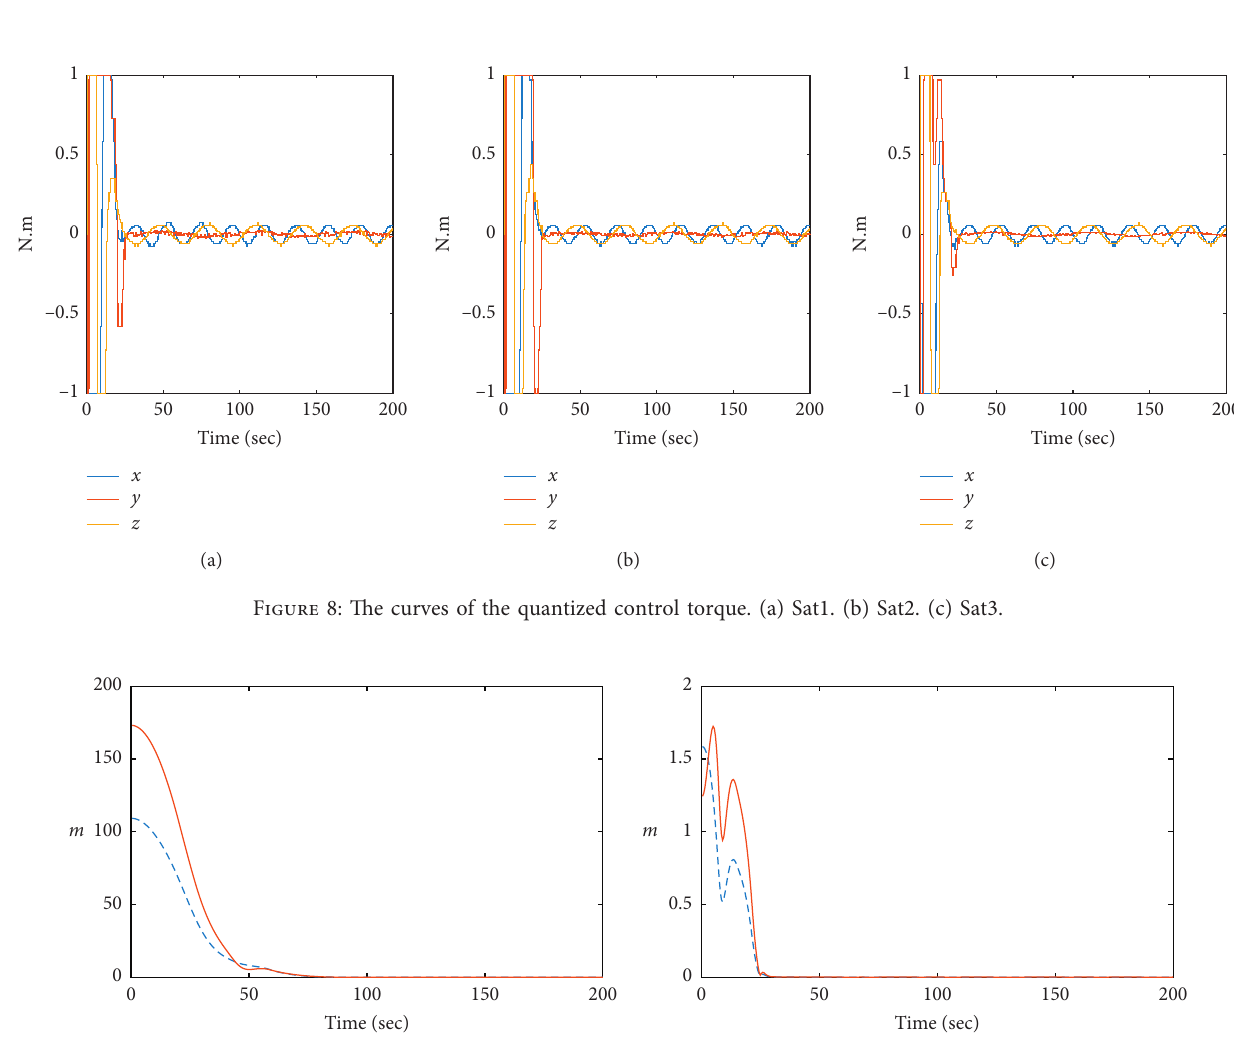
Figure 7: The curves of the quantized control force. (a) Sat1. (b) Sat2. (c) Sat3.